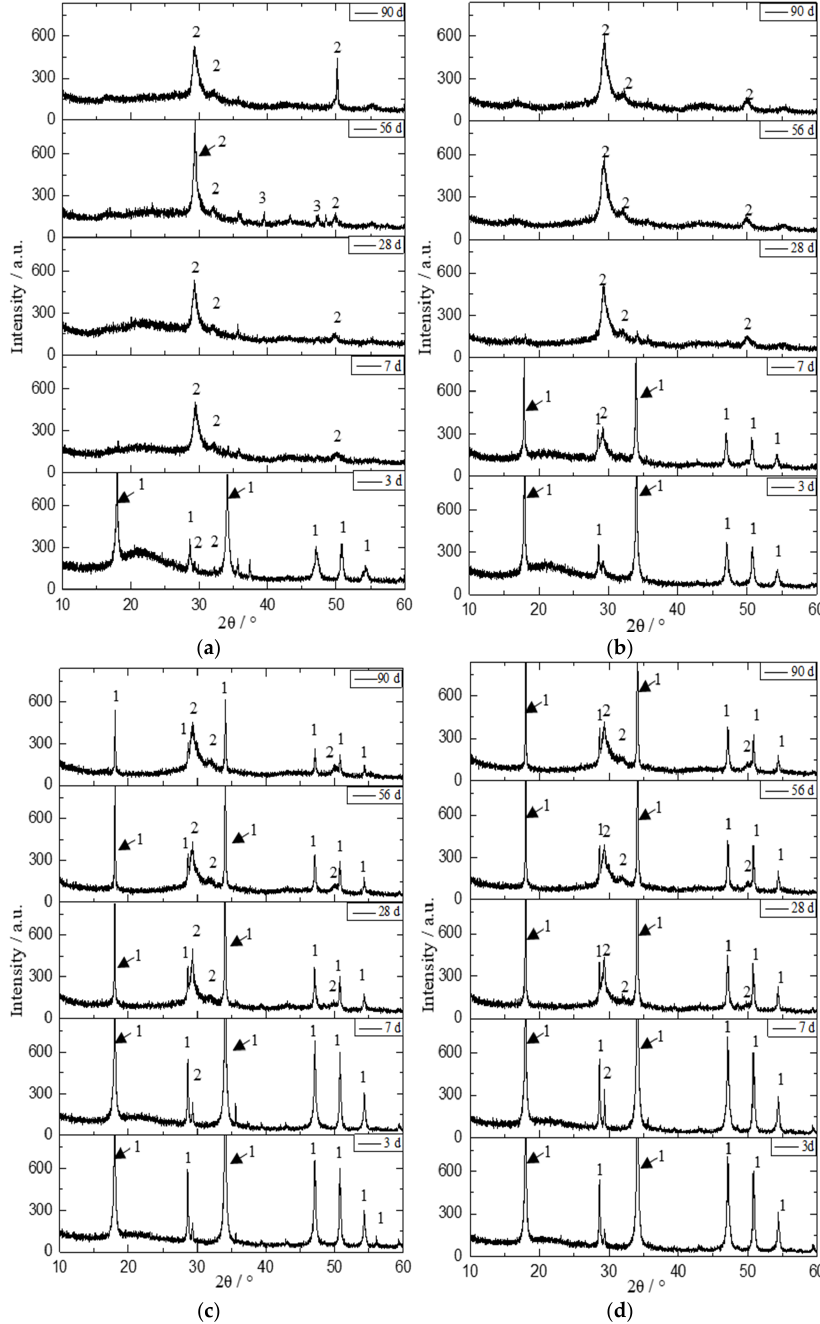
Figure 7. XRD patterns of samples with different curing times: ( a ) initial C/S molar ratio 0.5; ( b ) initial C/S molar ratio 1.0; ( c ) initial C/S molar ratio 2.0; and ( d ) initial C/S molar ratio 2.5. The as- signment of the peaks is marked using the following abbreviations: 1—portlandite, 2— Ca 1.5 SiO 3.5 · x H 2 O, 3—CaCO 3 (PDF#47-1743).